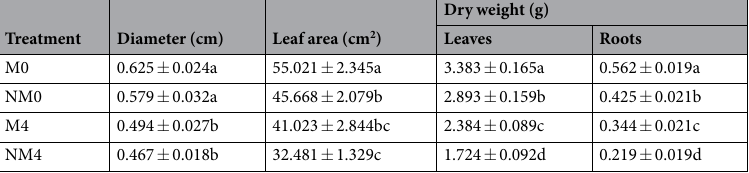
Table 1. Growth characteristics of seedlings of Neva irrigated with magnetized and non-magnetized brackish water for 30 days. Data in the table are the means ± SEs of at least three replicates. Values followed by different lowercase letters indicate significant differences at the 0.05 probability